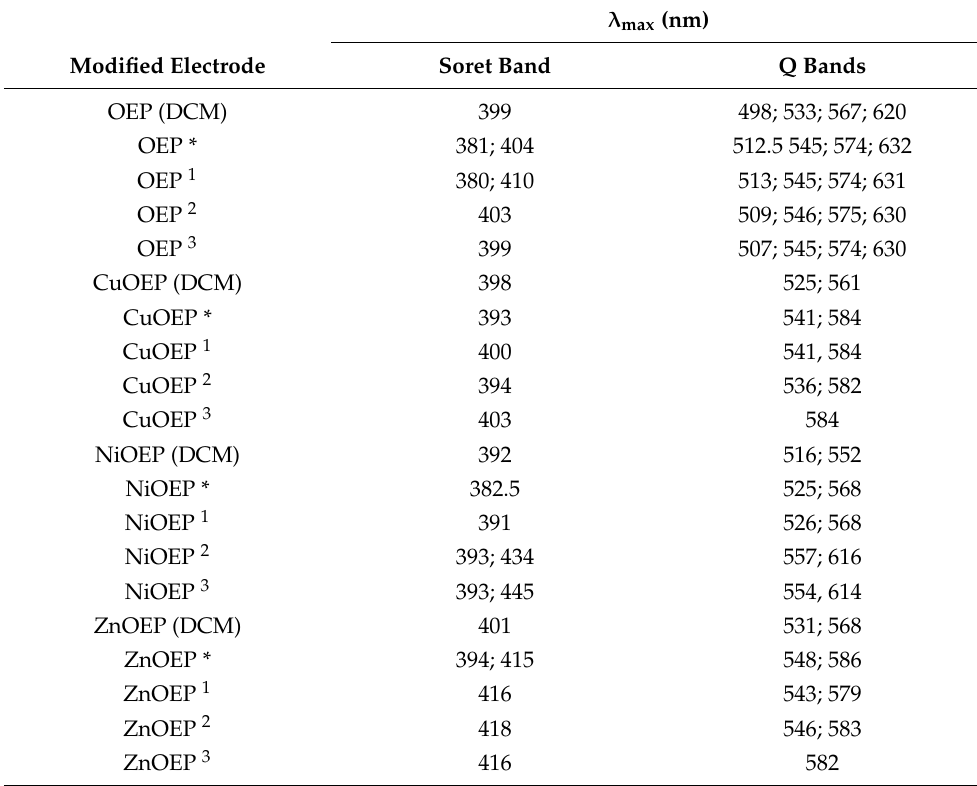
Table 2. Spectroscopic data of the monomers and polymers obtained in different potential range. λ max (nm) Modified Electrode Soret Band Q